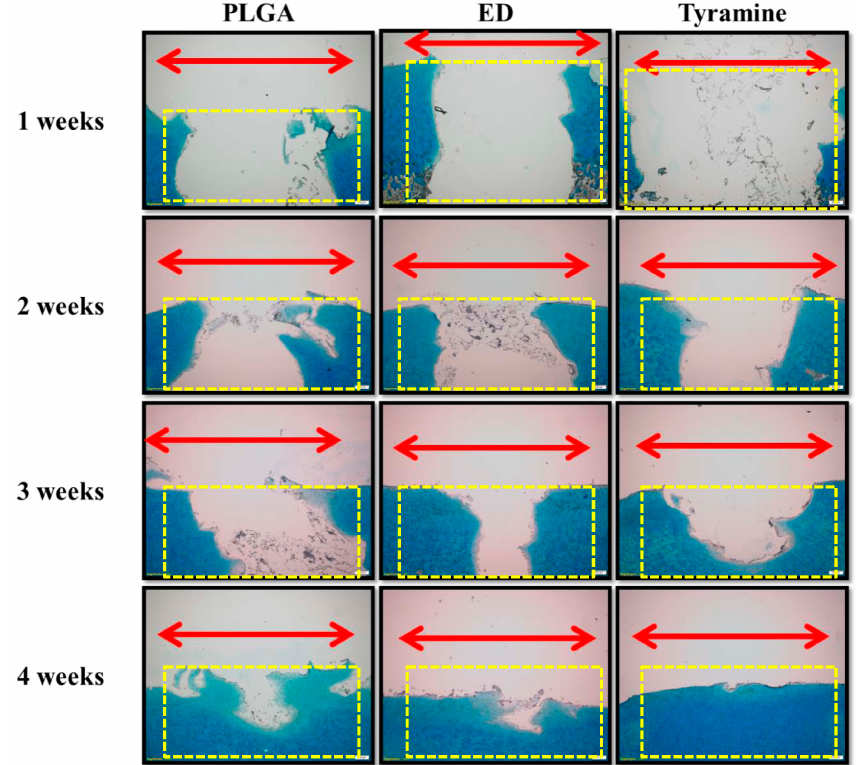
Figure 5. Histological analysis of co-cultured bilayered PLGA scaffold and porcine osteochondral plug by hematoxylin and eosin staining. ( A ) Magnification: 40×; scale bar: 200 μ m. ( B ) Magnification: 100×; scale bar: 100 μ m. Red double-headed arrows ( ←→) indicate the defect area after tissue regeneration. Yellow dotted boxes indicate the defect area before tissue regeneration. White boxes indicate that the images of tissue regeneration area were amplified.